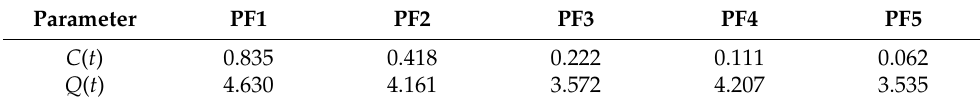
Table 2. Index values of different PF signal components (LMD).